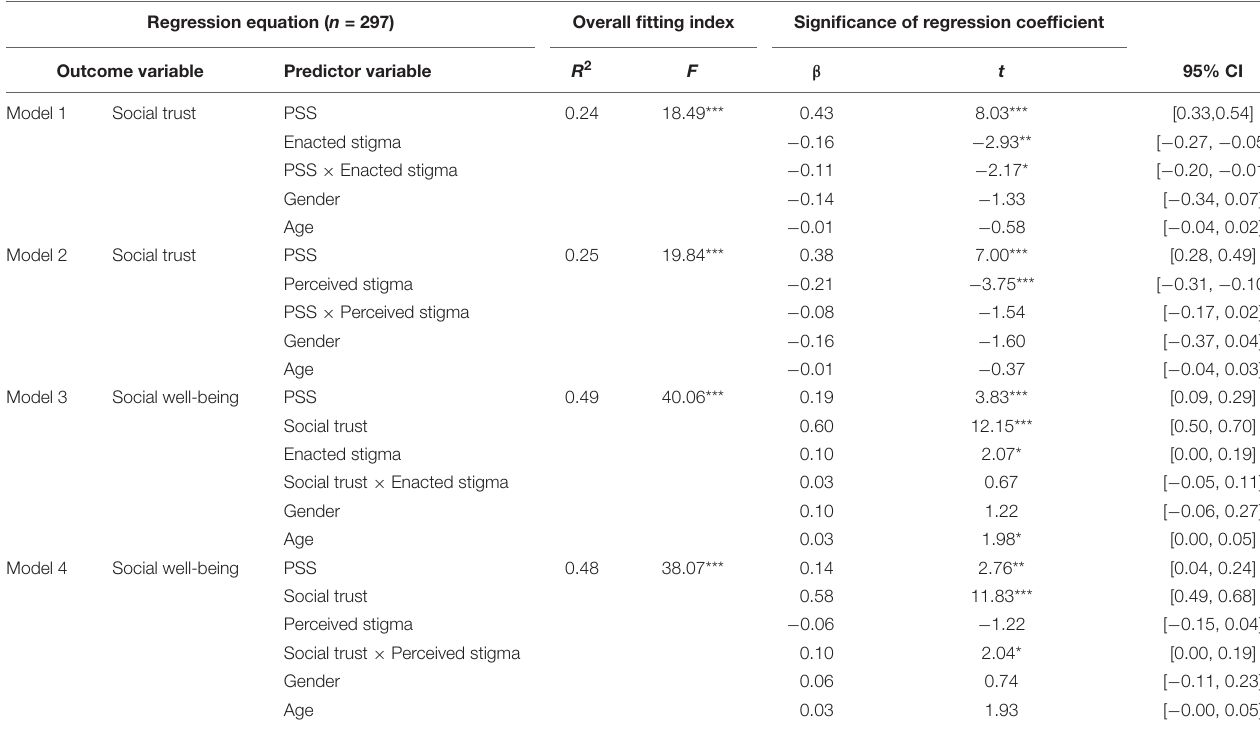
TABLE 3 | Moderated mediation effects test for HIV-related stigma. Regression equation ( n =